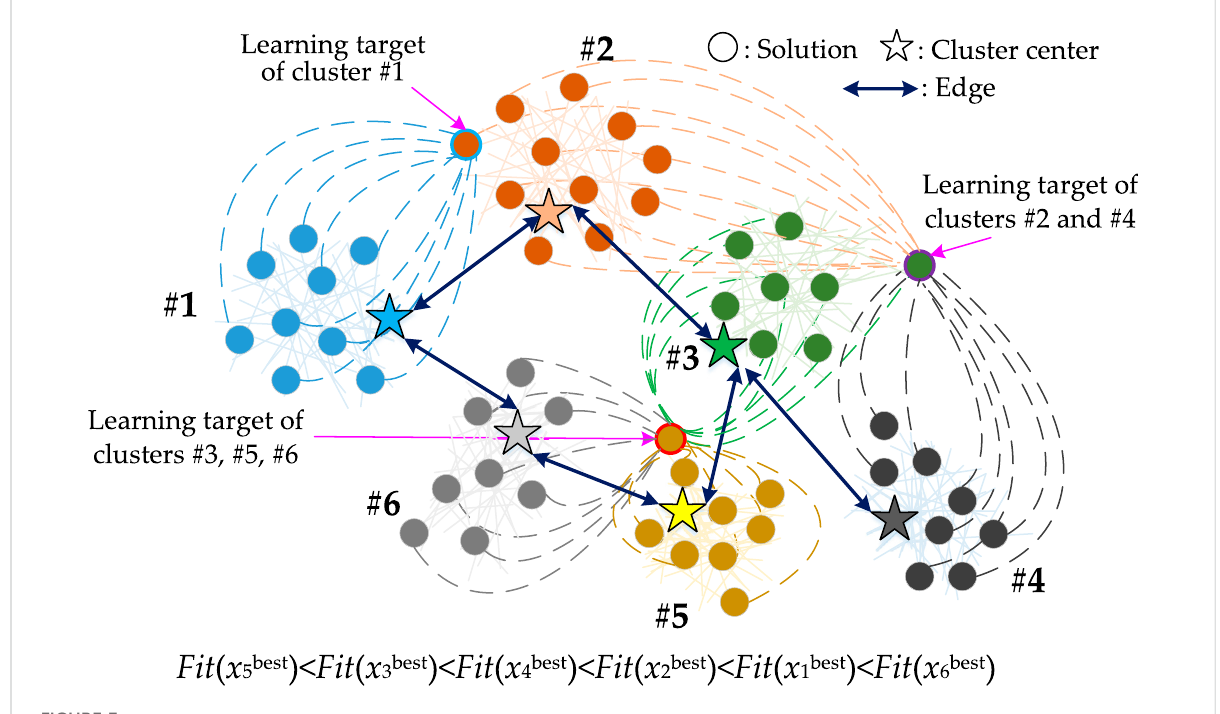
FIGURE 3 Illustration of the learning target-based searching phase of multiple interactive clusters in LALO.